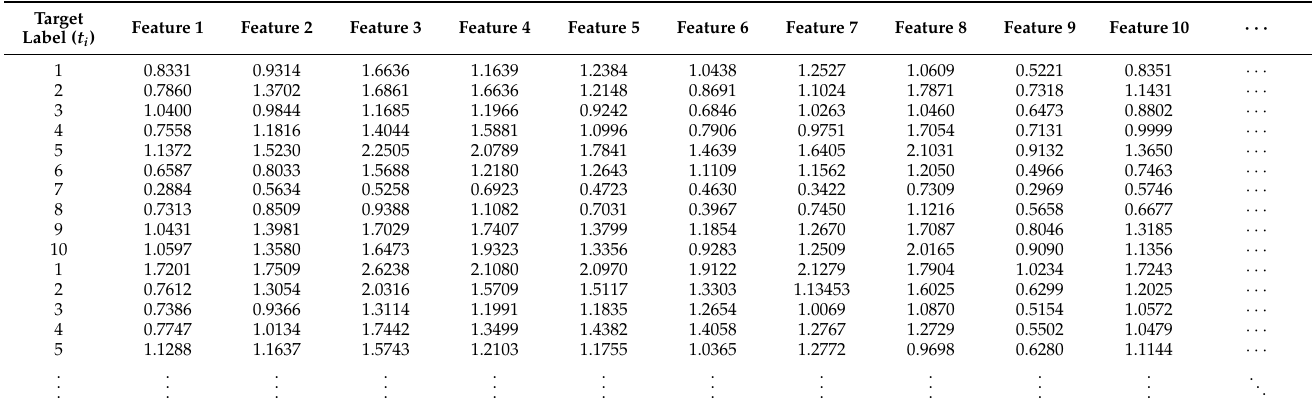
Table 3. The original annotated matrix X .